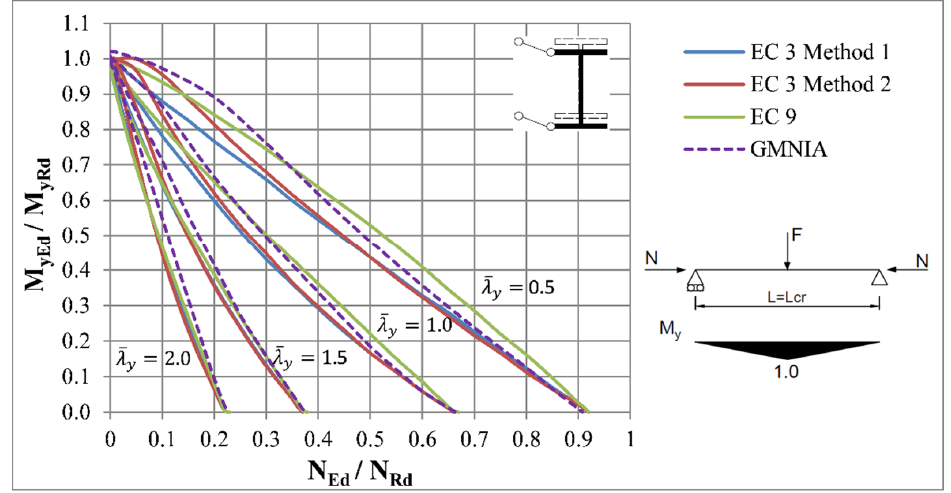
Figure 11. Interaction curves for laterally restrained beam-columns with IPE 100 cross-section.